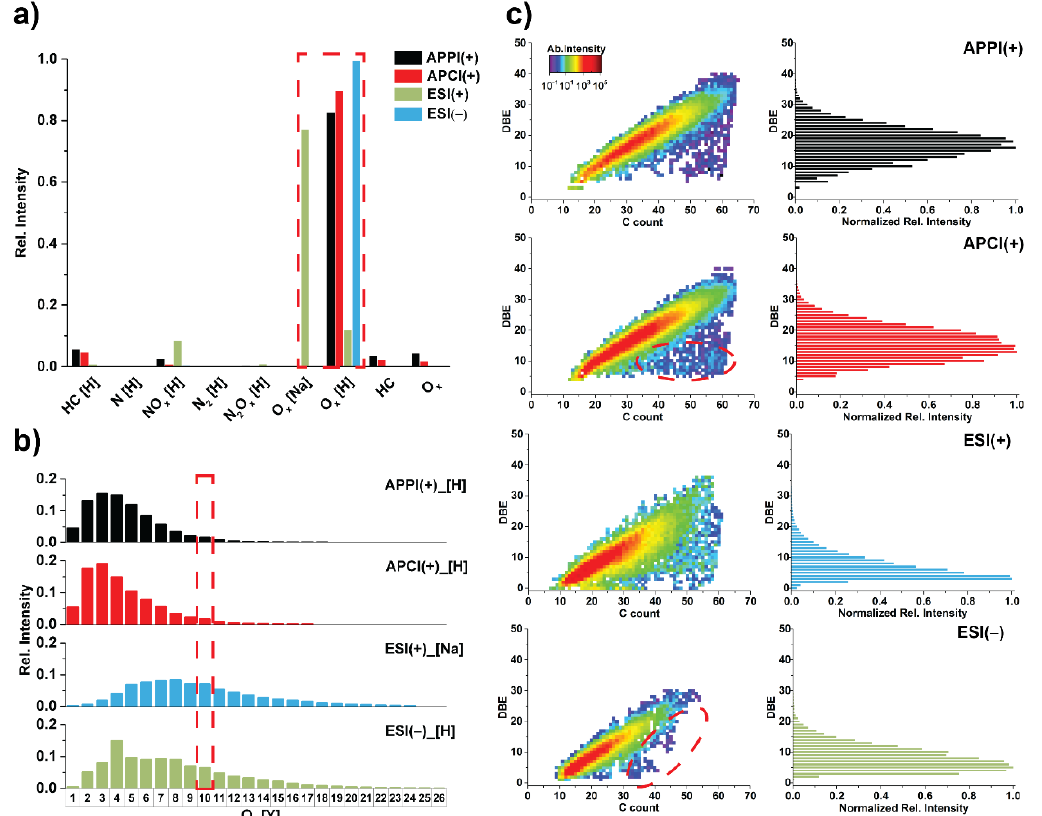
Figure 4. The impact of ionization techniques on the detection of molecular compositions: ( a ) Relative intensity-based class distribution for different ionization techniques. ( b ) Relative intensity-based class distribution for the O x [Y] classes (x: number of oxygen atoms per molecule, Y: type of ion (de-/protonated molecule or sodium adduct)). ( c ) The left-hand graph shows the Kendrick plots for the O 10 class and the right-hand graph presents histogram plots of DBE vs. normalized intensity.